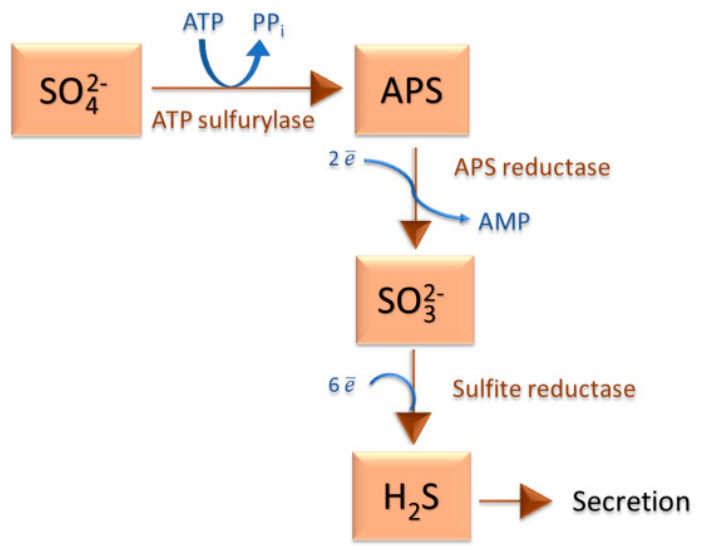
Figure 1. Scheme of the dissimilatory sulfate reduction.